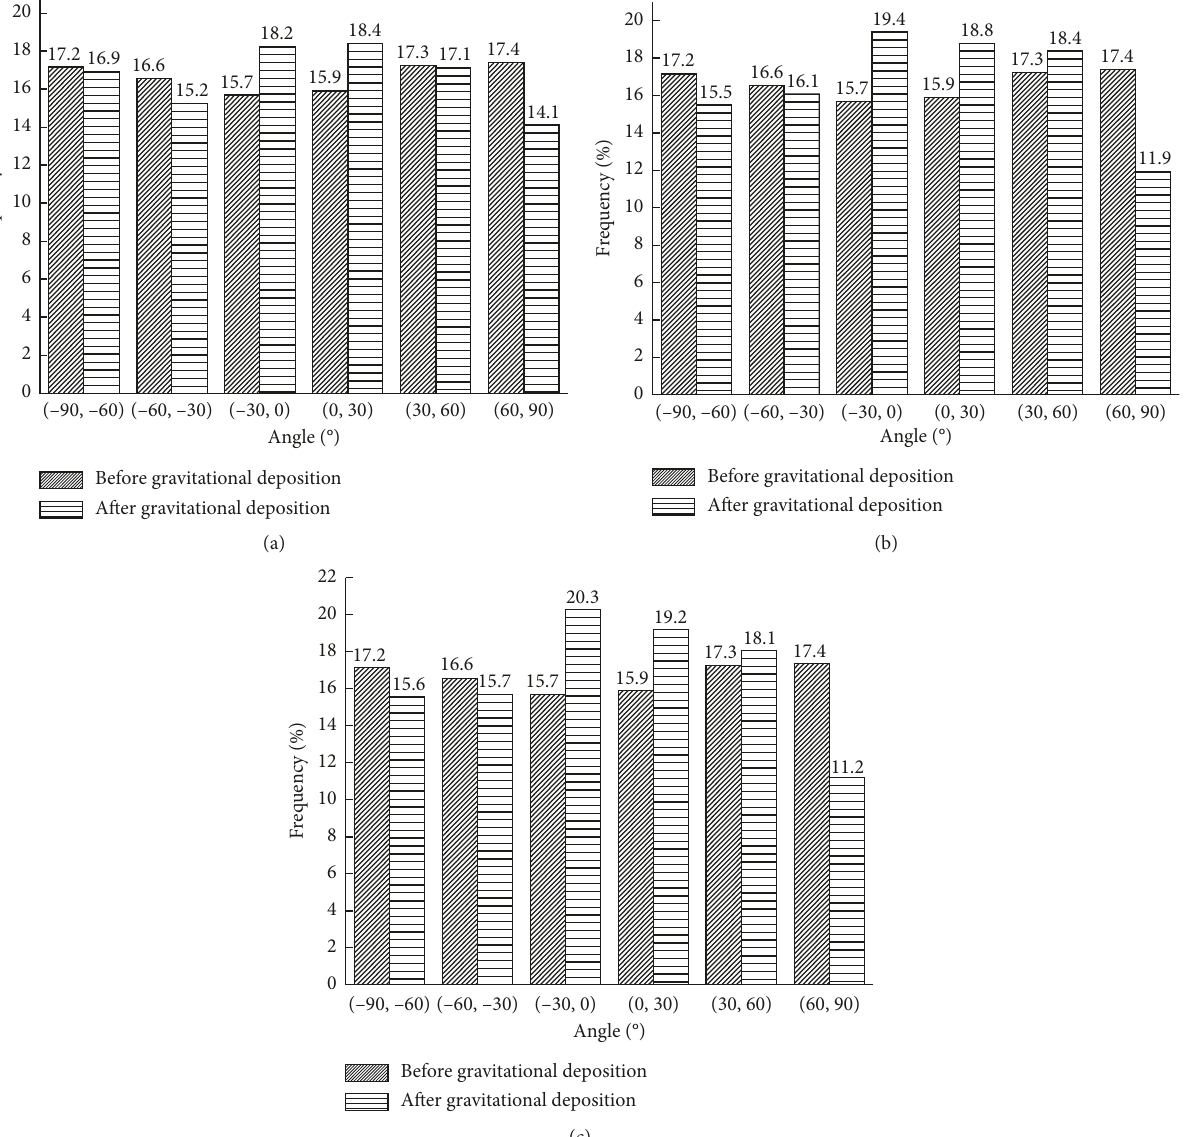
Figure 8: Distribution of the major axis orientation of particles: (a) 9,000 deposition steps; (b) 12,000 deposition steps; (c) 15,000 deposition